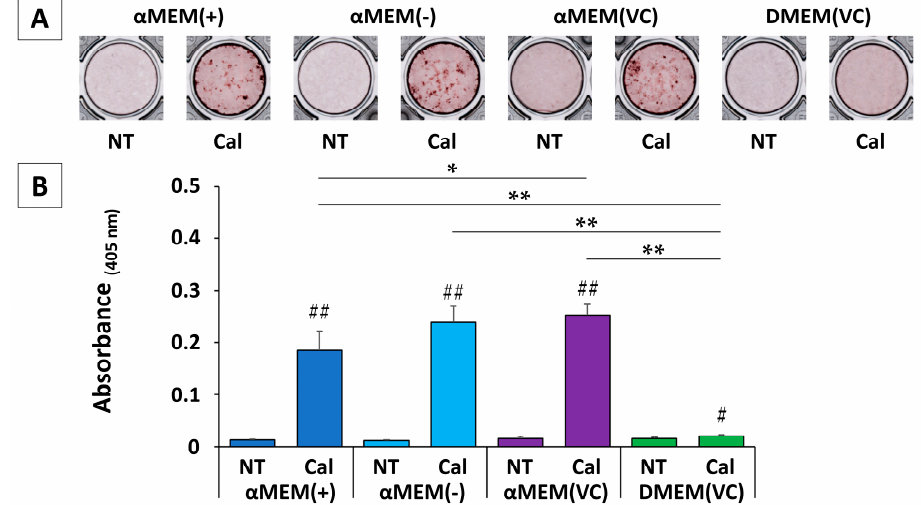
Figure 3. Calcification in MC3T3-E1 cells after 21 d: ( A ) representative images of Alizarin Red S (ARS) staining in various media in nontreated (NT) vs. calcification (Cal) conditions. ( B ) Solutions of mineral nodules eluted by agitation with 5% formic acid for 10 min were measured and quantified by absorbance at 405 nm ( n = 4, * p < 0.05, ** p < 0.01, # p < 0.05, ## p < 0.01): * multiple group comparison among calcification (Cal) media; # two-group comparison between NT and Cal